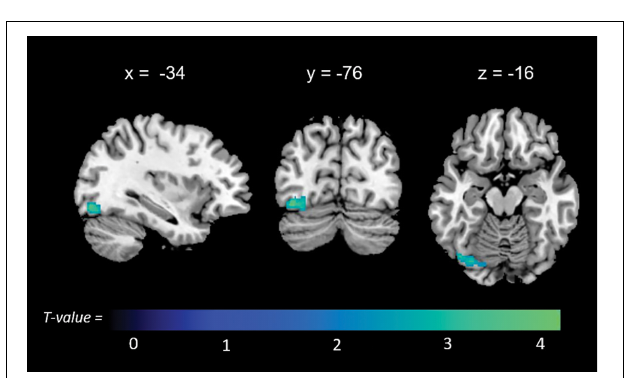
FIGURE 2 | Positive correlations between functional connectivity of the right frontoparietal network (r-FPN) and total anosognosia.